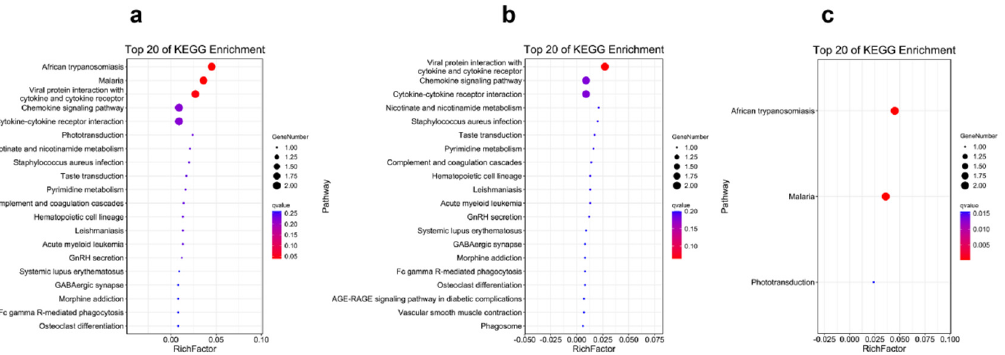
Figure 6. The Top 20 KEGG Pathways Enriched by the Differentially Expressed Genes in the Spleen at 48 h Postinjection: ( a ) the Top 20 Enrichment Pathways among All Differentially Expressed Genes; ( b ) the Top 20 Enrichment Pathways among the Upregulated Differentially Expressed Genes; ( c ) the Top 20 Enrichment Pathways among the Downregulated Differentially Expressed Genes.